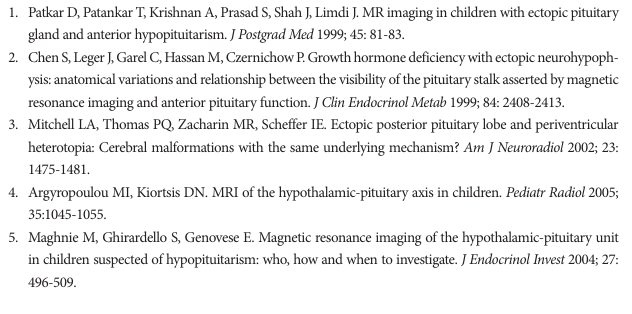
Fig. 3d. A coronal STIR inverted image demonstrating the clump-like periventricular grey matter